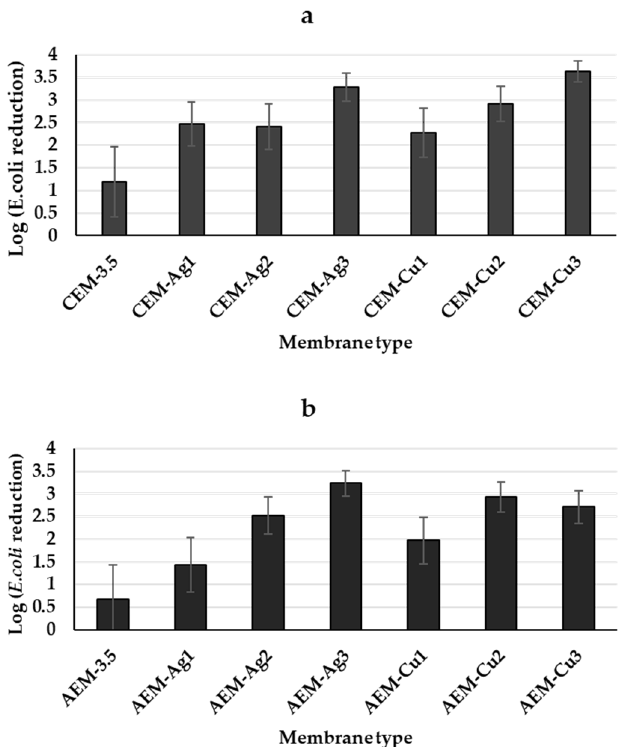
Figure 9. Log reduction in E. coli bacterial count after permeation through the modified Ag and Cu ( a ) CEM nanocomposite and ( b ) AEM nanocomposite with different Ag and Cu contents in the membranes. Initial bacterial concentration: 1.82 × 10 9 CFU/mL (log 9.26 ± 0.62). Error bars represent the standard